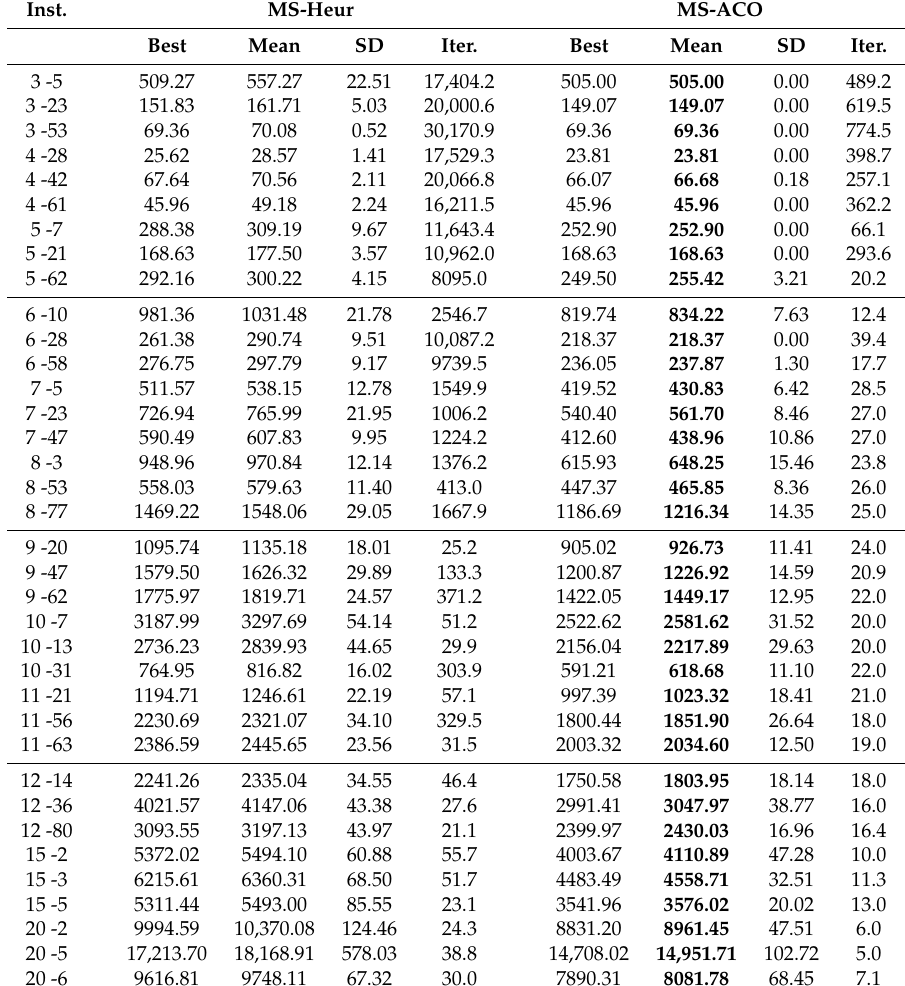
Table 1. MS with ACO. For 25 runs conducted, the best ( Best ) and average ( Mean ) solution qualities with associated standard deviations ( SD ) are provided. The table also shows the average number of iterations ( Iter .) conducted for each problem instance. Statistically significant results, using a pairwise t -test, at the 95% confidence interval are highlighted in boldface. Inst.